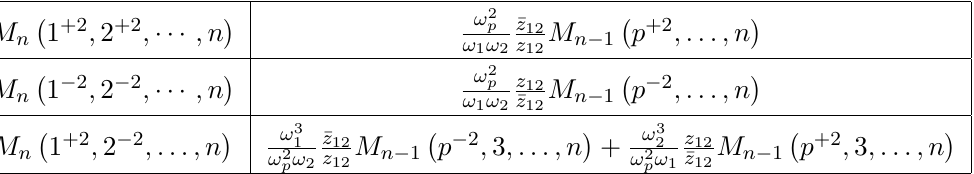
Table 4 . Amplitude corresponding to two collinear